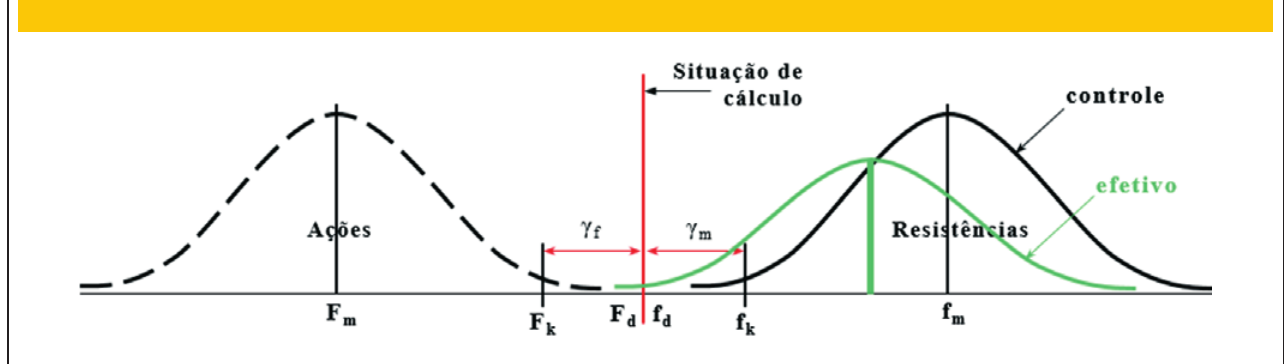
Figure 1 – Representation of safety analysis according to probabilistic